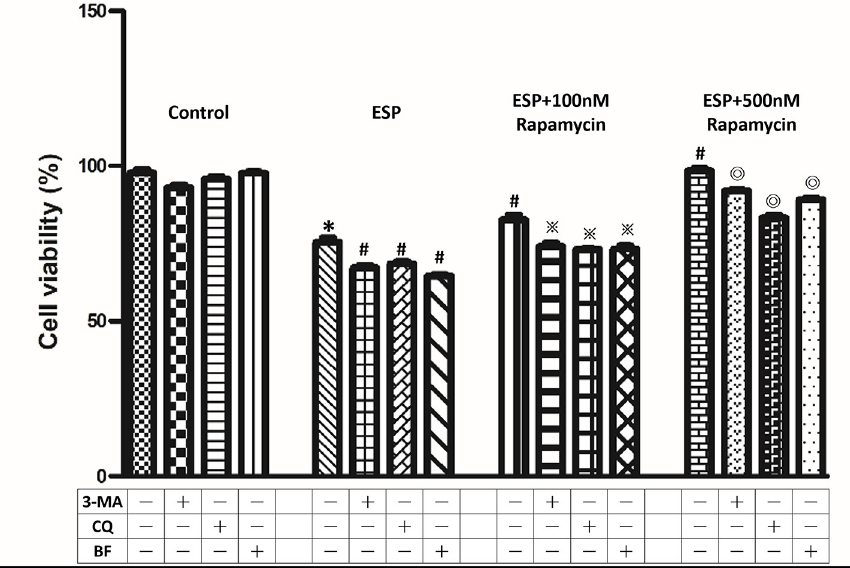
Fig 6. Rapamycin protects astrocytes upon excretory/secretory product treatment via autophagy induction. Cells were pretreated with rapamycin, 3-methyladenine (3-MA), chloroquine (CQ), or bafilomycin A1 (BF) for 1 h and then incubated with 500 μ g/ml A . cantonensis L5 excretory/secretory products (ESPs) for 12 h. The viability of astrocytes was analyzed by the CCK-8 assay. The data are expressed as the means ± SD from three independent experiments ( n = 3). � P < 0.01, compared with the control. # P < 0.01, compared with the cells exposed to ESPs. ※ P < 0.01, compared with the cells exposed to ESPs+100 nM rapamycin. ◎ P < 0.01, compared with the cells exposed to ESPs+500 nM